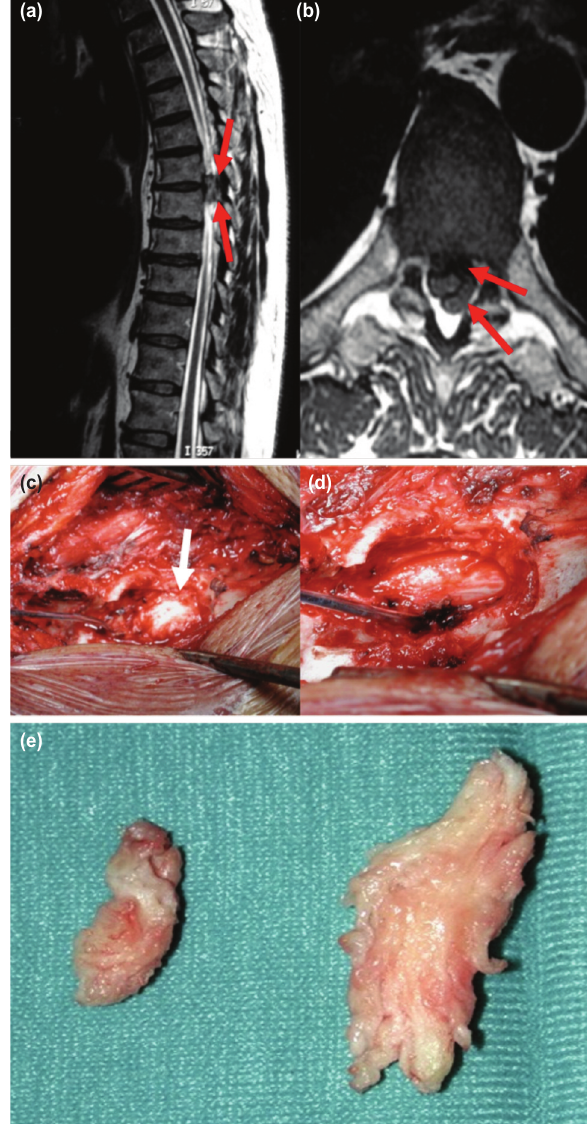
(a,b) T2-weighted MRI images of the thoracic spine that Fig. 2: showed a large herniated disc fragment migrated posteriorly that caused cord compression. The severity of the cord compression was more evident on the axial plane. after posterior laminectomy (c) before and (d) after herniated disc removal. (e) Macroscopic image of the fragment of disc surgically